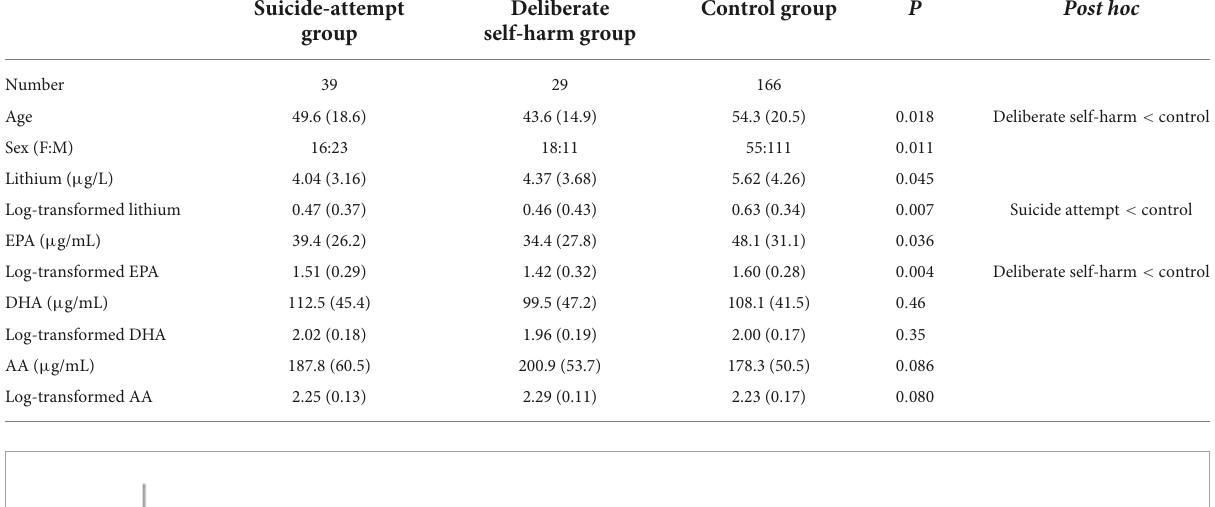
TABLE 1 The characteristics of patients and lithium, EPA, DHA, AA levels and their log-transformed values in the suicide-attempt group, deliberate self-harm group, and control group. Suicide-attempt Deliberate Control group group self-harm group